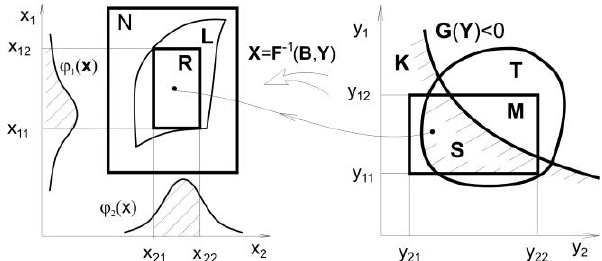
Fig. 2. Obtaining independent intervals of